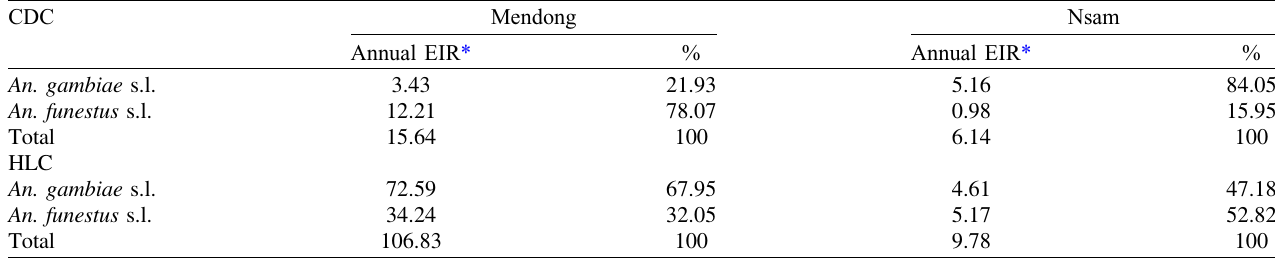
Table 6. Estimation of the entomological inoculation rate (EIR) using CDC light traps or human landing catches in Nsam and Mendong. CDC